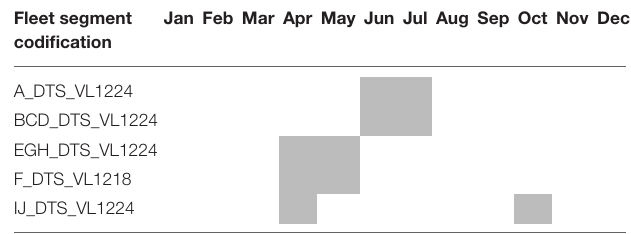
TABLE 3 | Differentiated fishing ban related to scenario